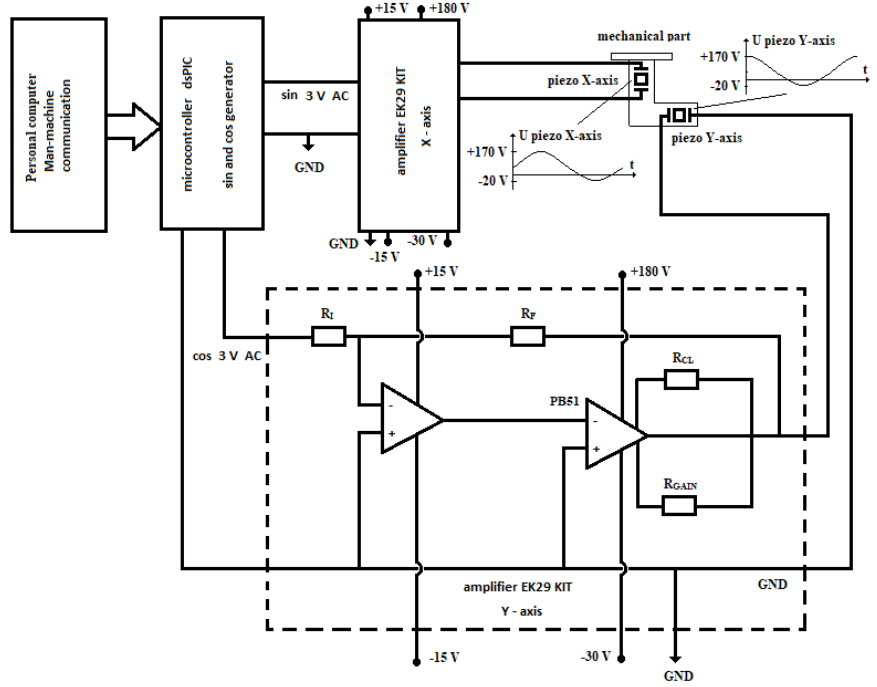
Figure 2. Electronic part of the laboratory set-up with two EK29 KIT high voltage amplifiers.